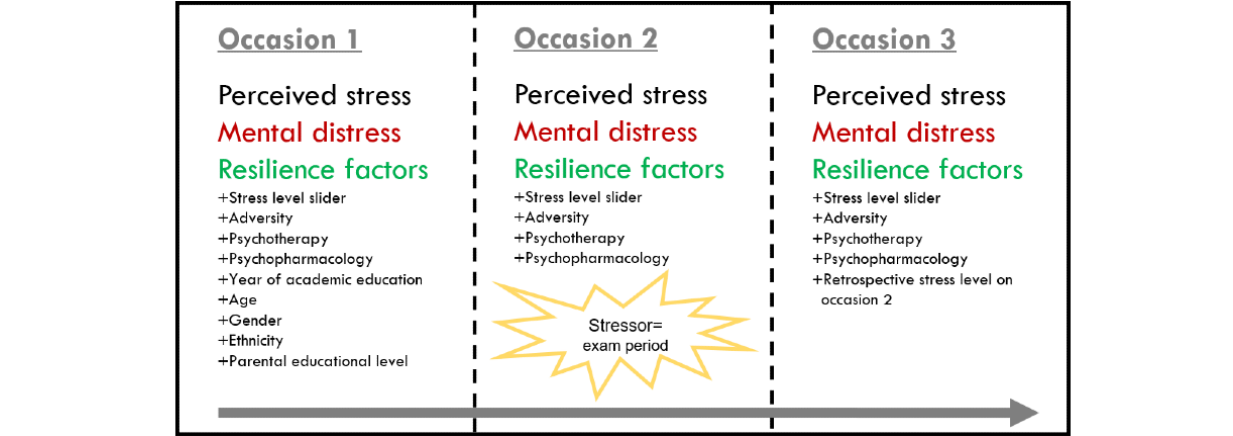
Figure 1. Study design. The Figure depicts the measures that have been assessed on the 3 occasions.